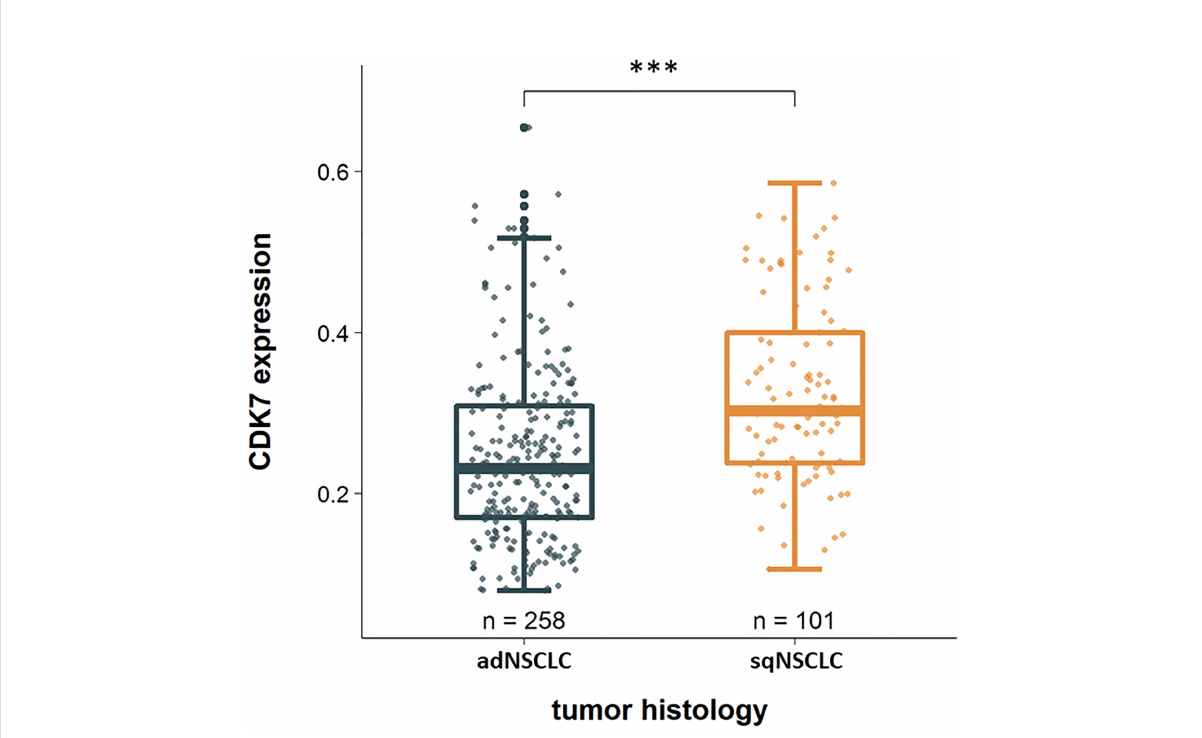
FIGURE 2 CDK7 expression in dependency of tumor histology. CDK7 is signi fi cantly higher expressed in sqNSCLC compared to adNSCLC (*** p